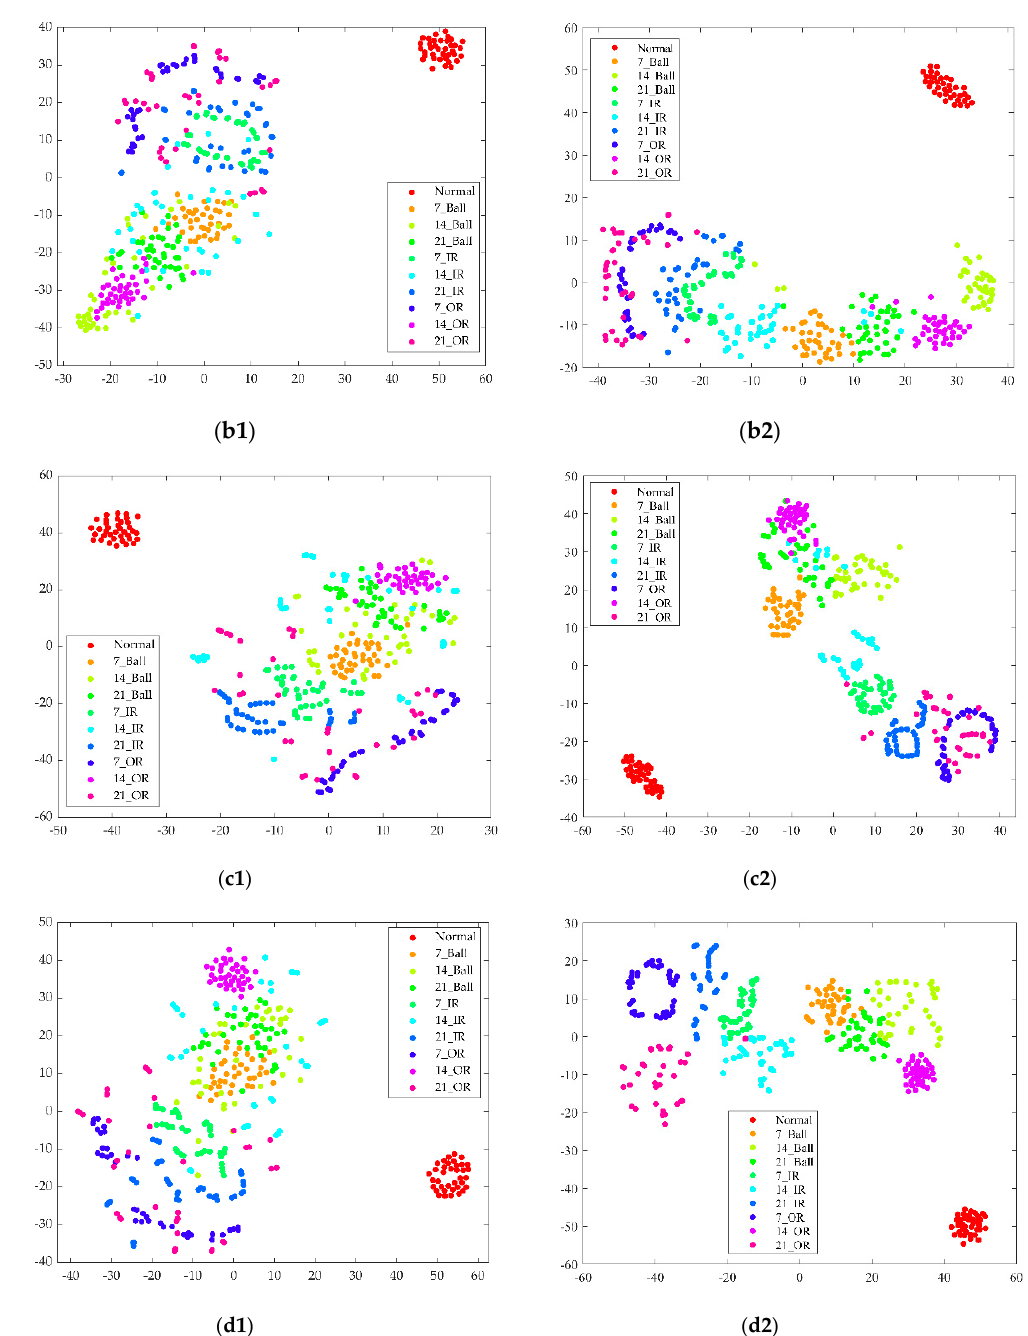
Figure 11. T-SNE visualization of features learned in the fully connected layer: ( a1 ), (b1), (c1) and (d1) are the features of CNN learning from testing Dataset A, B, C and D, respectively. (a2), (b2), (c2) and (d2) are the features of CNNEPDNN learning from testing Dataset A, B, C and D, respectively. ( d2 ) are the features of CNNEPDNN learning from testing Dataset A, B, C and D,